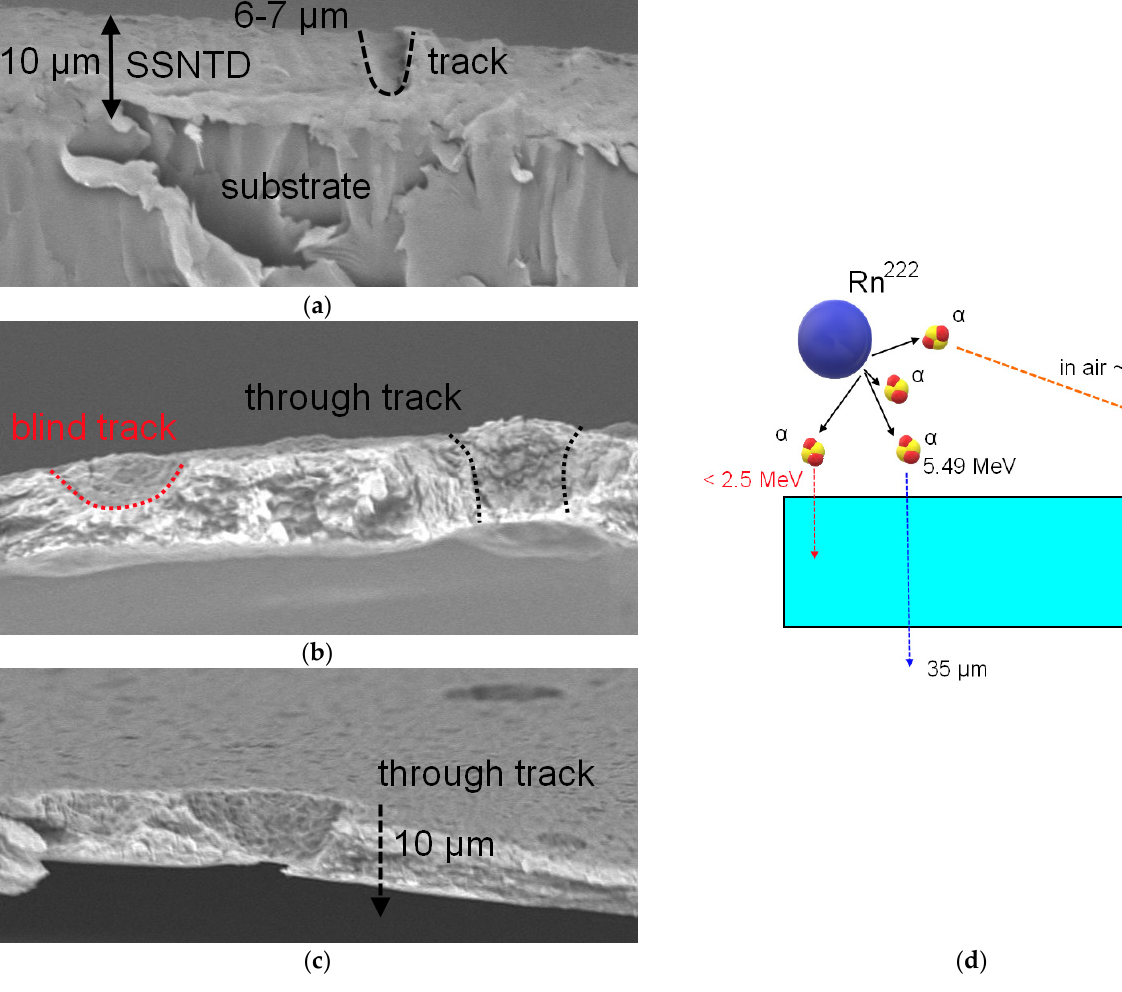
Figure 4. SEM images of side cleavages of the studied film samples: ( a ) sample 1; ( b ) sample 4; ( c ) sample 3; ( d ) schematic representation of the detection of α -particles by film detectors. Table 1. Radon volumetric activity data (the measurement data presented in the table were de- termined by calculating the density of latent tracks and the volumetric activity for all studied films with further determination of the average value and standard deviation ).